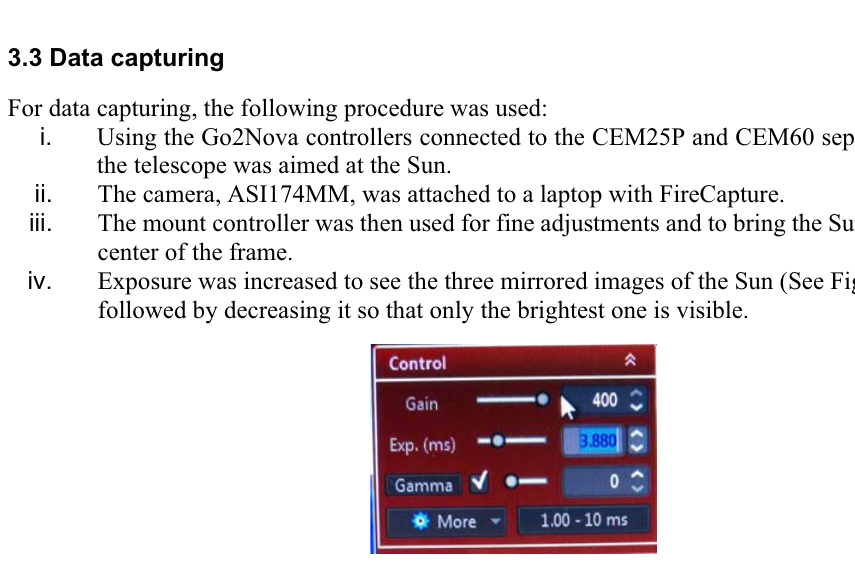
Figure 8. Increasing Exposure on FireCapture